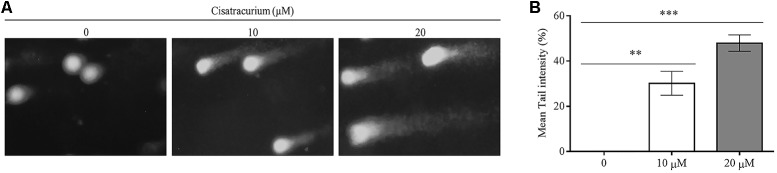
(A,B) Cisatracurium induces DNA damage in HTC cells. (A) Genotoxic assessment illustrates typical comet images from HTC116 cells treated with cisatracurium. It indicates different levels of damage: control (0), undamaged (no tail DNA); 10 and 20 μM shows increasing levels of damage. The number of cells scored in each measured concentration was 50. (B) Bar chart of mean tail comet in percentage [∗∗p < 0.01 and ∗∗∗p < 0.001 versus untreated (0)].